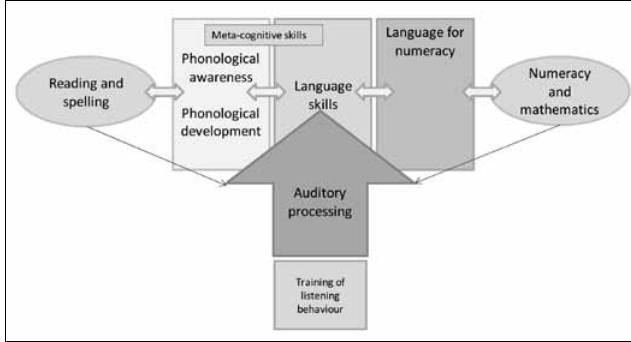
Fig. 2. The relationship between listening, language, literacy and